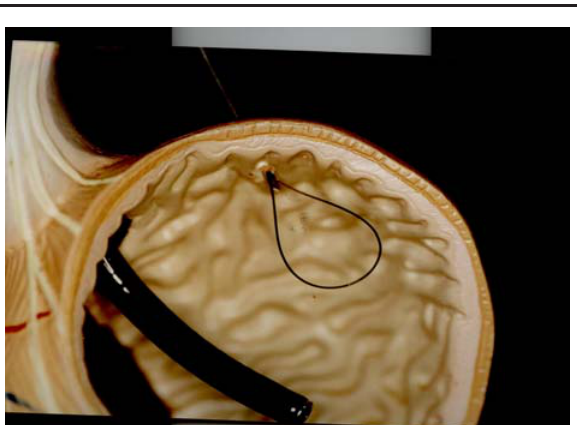
FIGURE 2 - Folded mononylon passed through inside lumen of peridural needle Nº